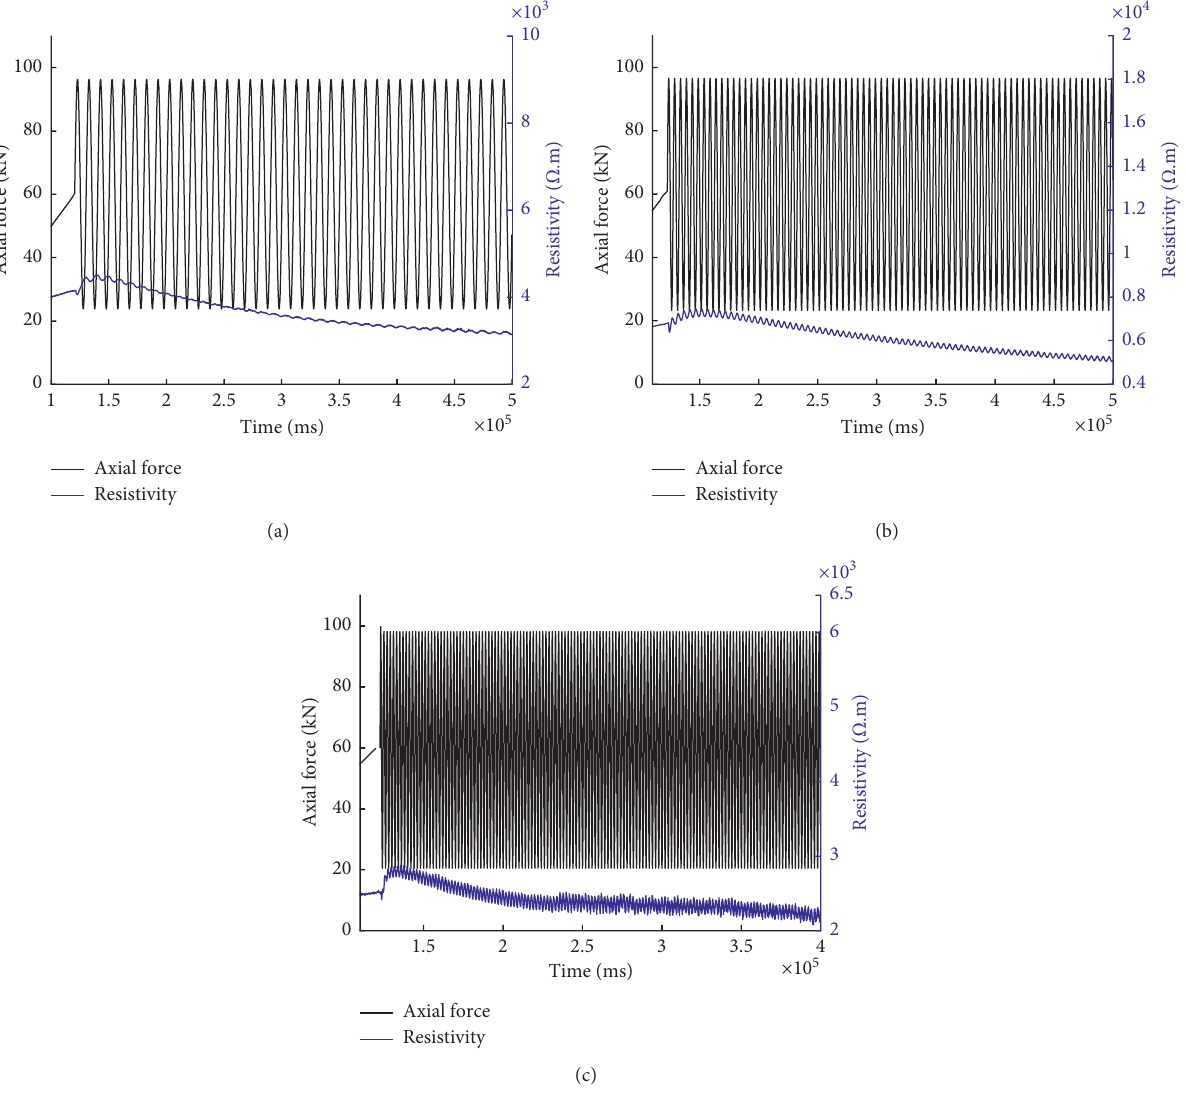
Figure 9: Resistivity evolution of sandstone under different loading frequencies. (a) Resistivity evolution law of frequency at 0.1Hz. (b) Resistivity evolution law of frequency at 0.2Hz. (c) Resistivity evolution law of frequency at 0.5Hz.